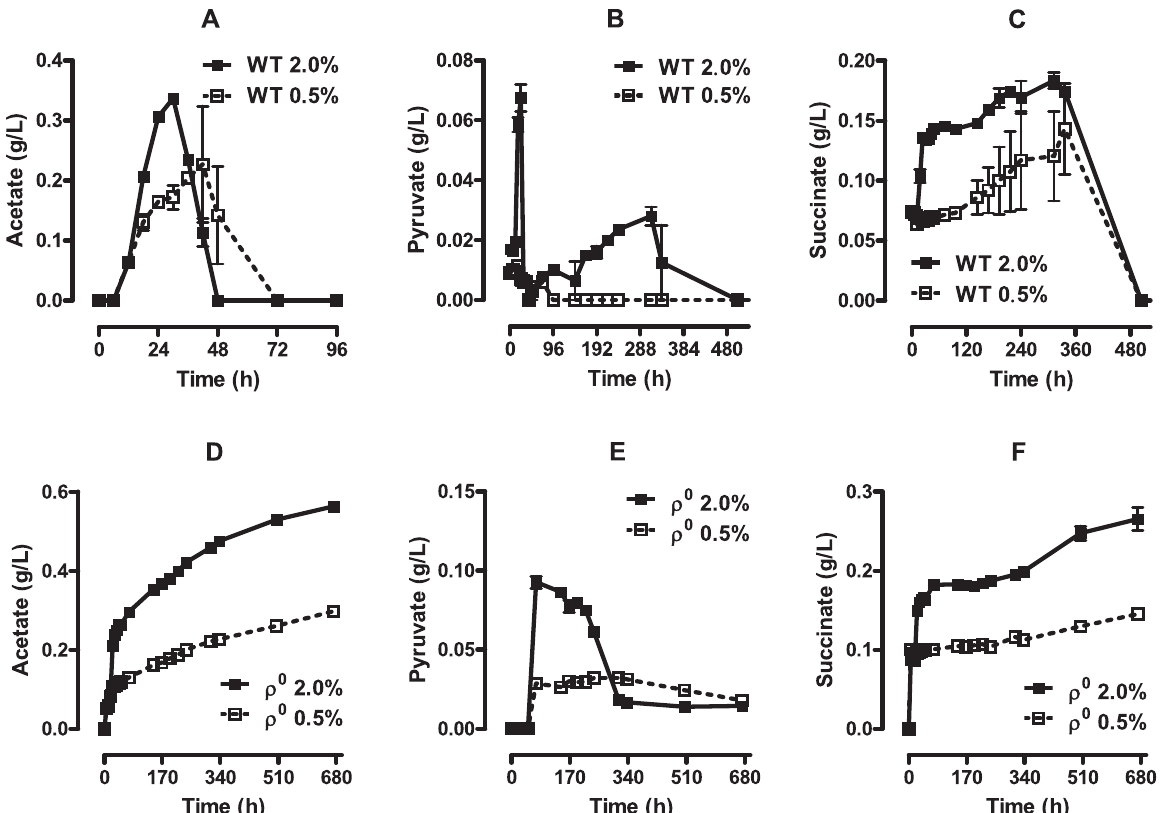
Figure 4. Acetate, pyruvate and succinate levels during chronological aging. Acetate (Panels A and D), pyruvate (Panels B and E) and succinate (Panel C and F) concentrations in the culture media during WT (Panels A-C) and r 0 (Panels D-F) S. cerevisiae chronological lifespan were measured as described in Materials and Methods. doi:10.1371/journal.pone.0056388.g004 PLOS ONE |